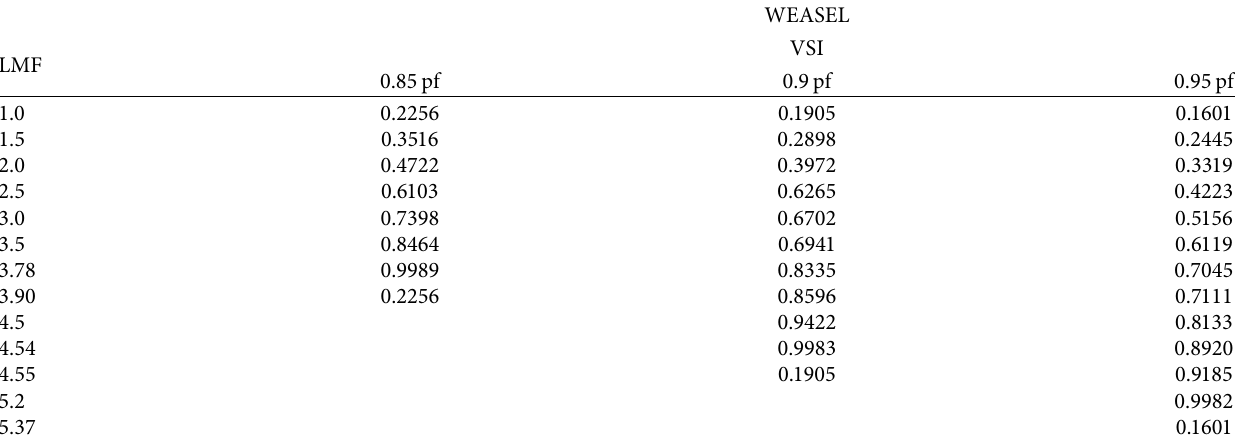
Table 5: Stability points of the WEASEL conductor.